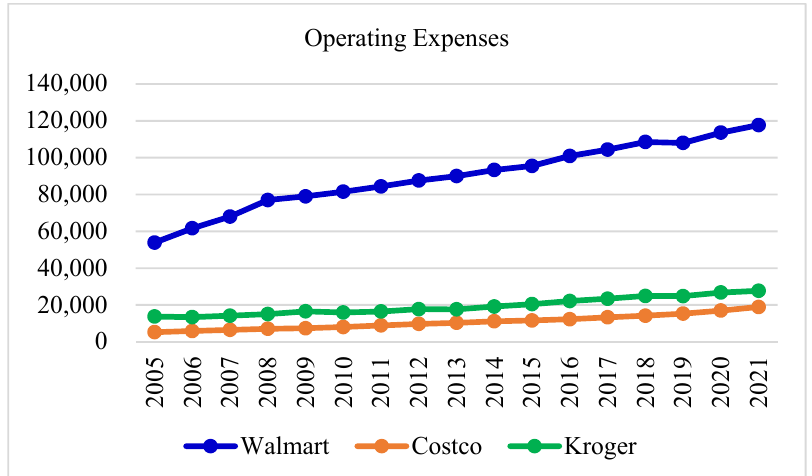
Figure 10. Operating expenses in millions $USD. Table 8. Correlation coefficients between input and output variables.